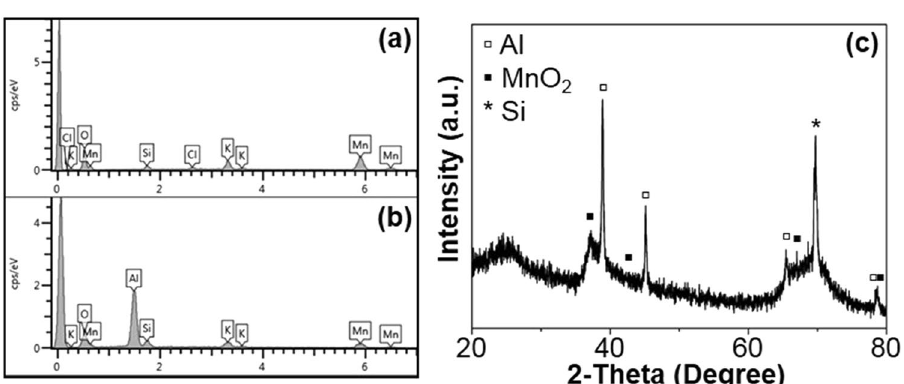
Figure 4. EDS patterns of ( a ) Si-W/MnO 2 and ( b ) Si-W/MnO 2 /Al, and ( c ) XRD pattern of Si-W/MnO 2